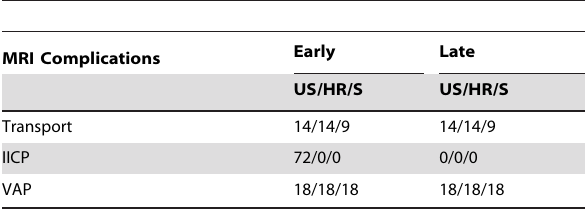
Table 2. MRI complications, early and late occurrence, expressed in percent probability according to categories of